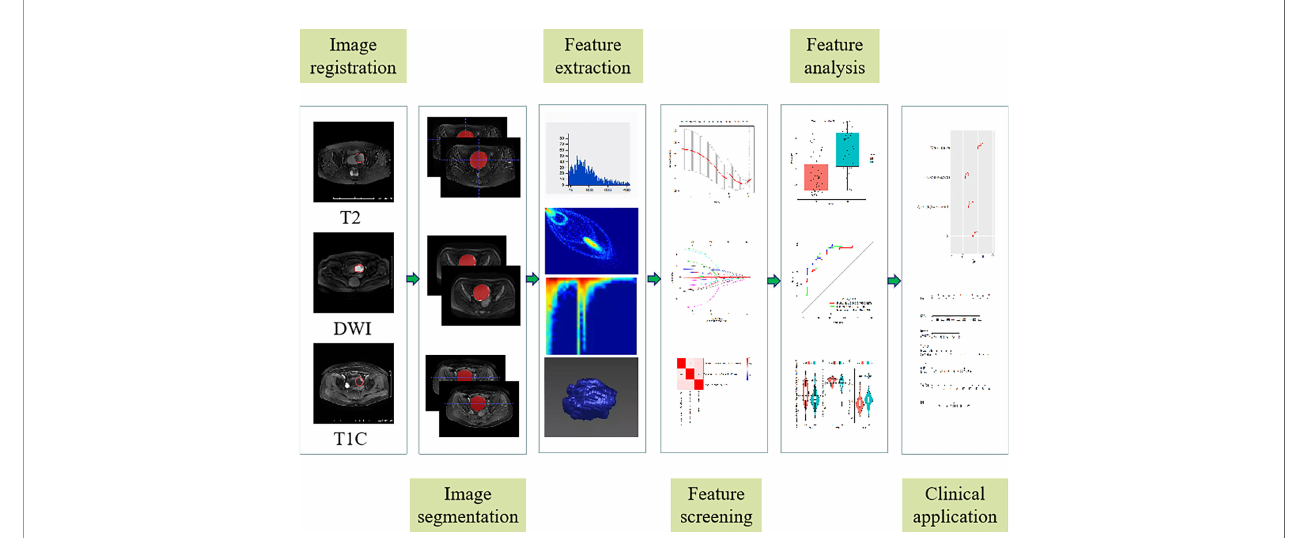
FIGURE 2 | Radiomics signature work fl